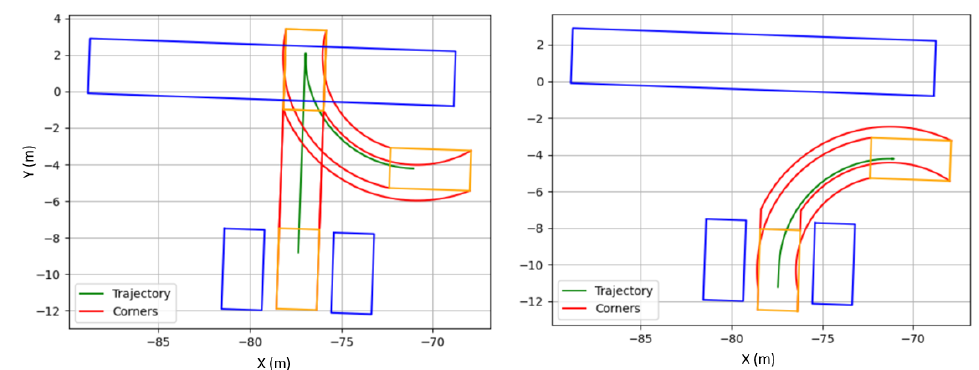
Figure 8. Battery parking collision check. Right : A valid trajectory. Left : a not valid trajectory. Blue boxes represent parked vehicles. Orange boxes represent the vehicle to be parked. Red lines represent the limits for the parking process, in order to detect collisions.